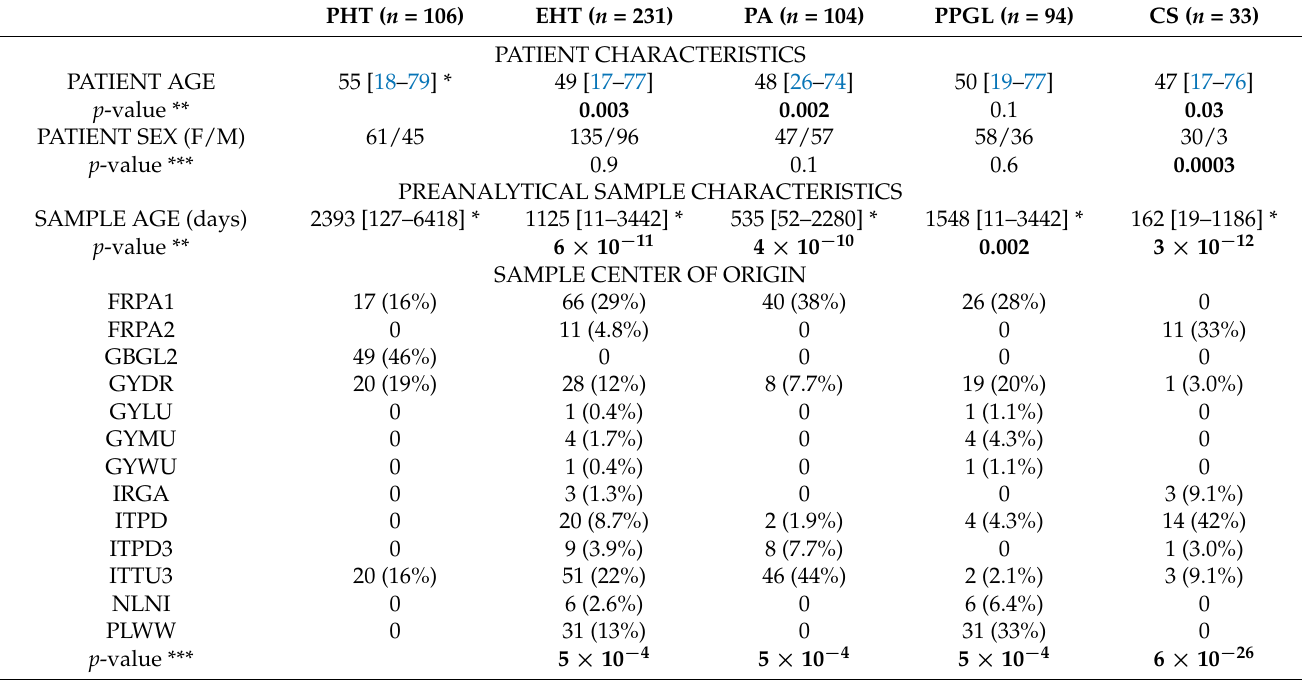
Table 1. Patient and sample characteristics. Abbreviations are explained in the main